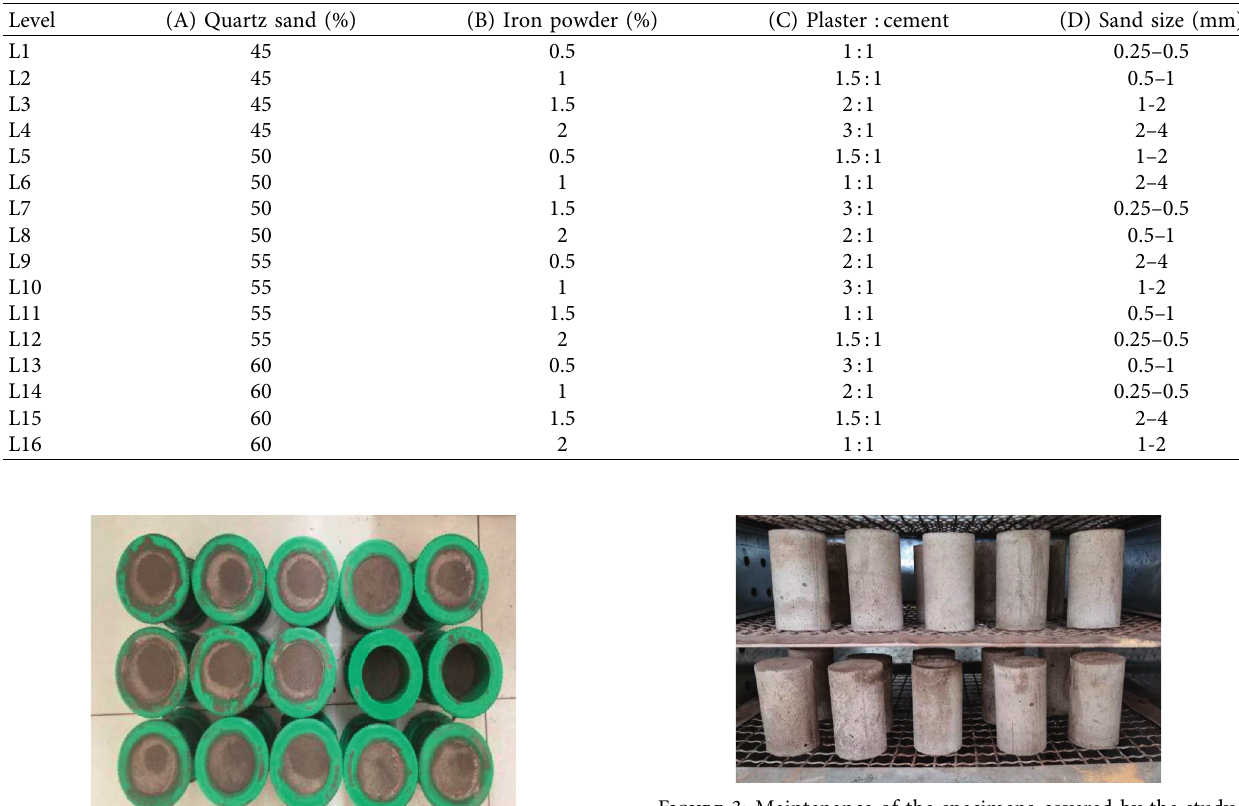
Table 3: Design table for orthogonal test covered by the study.